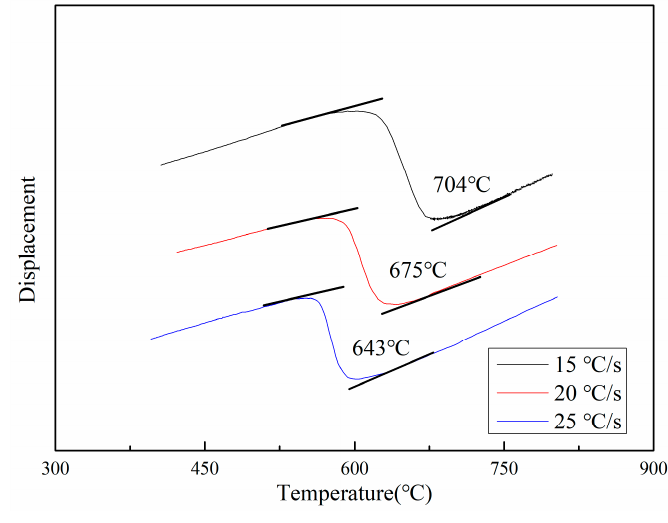
Figure 10. Expansion curves and Ar 3 measured at 15 °C/s, 20 °C/s, and 25 °C/s. The transformation products of PF, AF, and GBF were in sequence of the phase transition temperature domain, according to previous studies [24,25]. In addition, the PF/AF nucleates possibly at the Ti ‐ riched (Ti,V)(C,N) particles [10] and in the dislocation substructure [26]. Furthermore,